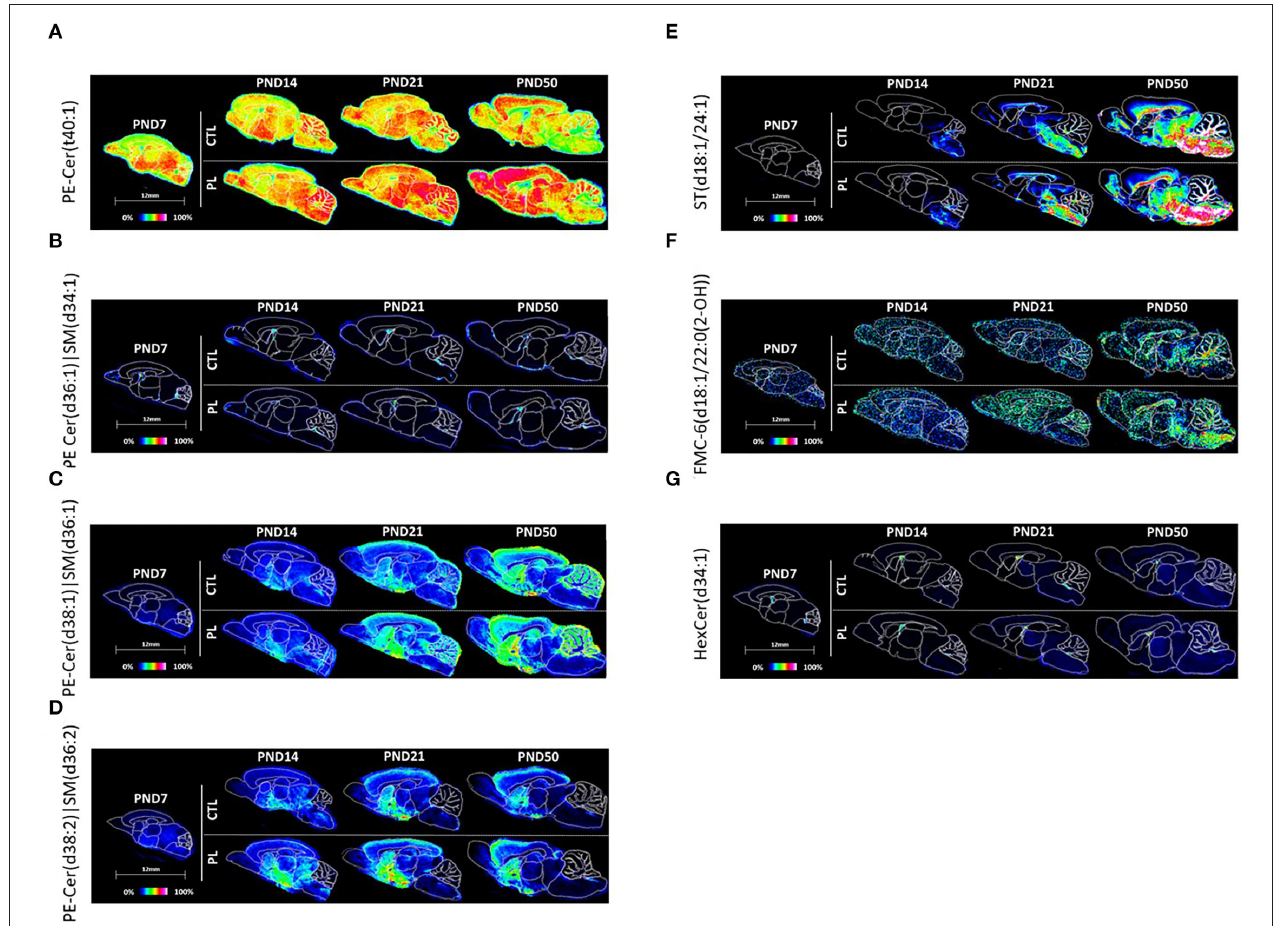
FIGURE 8 | Spatiotemporal distribution of sphingolipids. Representative MALDI-MSI images are shown for (A–D) phosphosphingolipids, (E) acidic and (F,G) neutral glycosphingolipids. Control sections are presented on the top. PL-supplemented sections are presented on the bottom. The age is indicated above the images. The signal intensity scale is normalized to 100% of maximum peak intensity across all